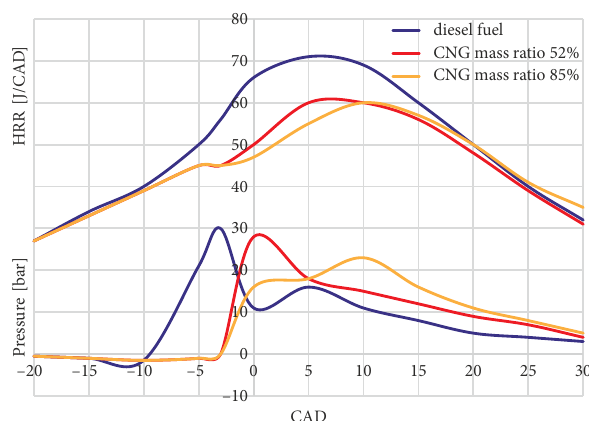
Figure 1. Combustion pressure and HRR at an 80% load and at 2000 rpm – is based on data from research by Papagiannakis and Hountalas (2003) and illustrates the principles of changing pressure and